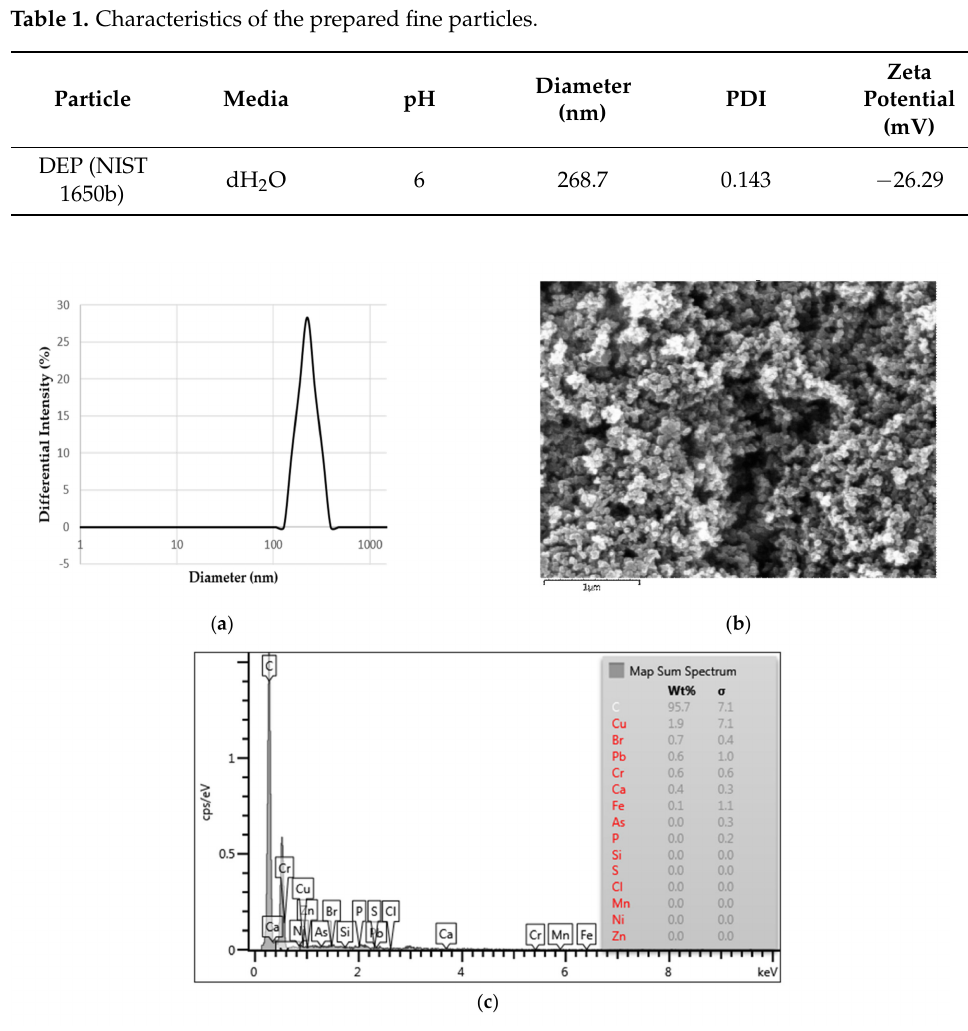
Figure 3. Physical and chemical information about the DEP (diesel exhaust particle). ( a ) The size dis- tribution of DEP in dH 2 O; ( b ) SEM image of DEP; ( c ) EDX (energy-dispersive X-ray) spectrum of